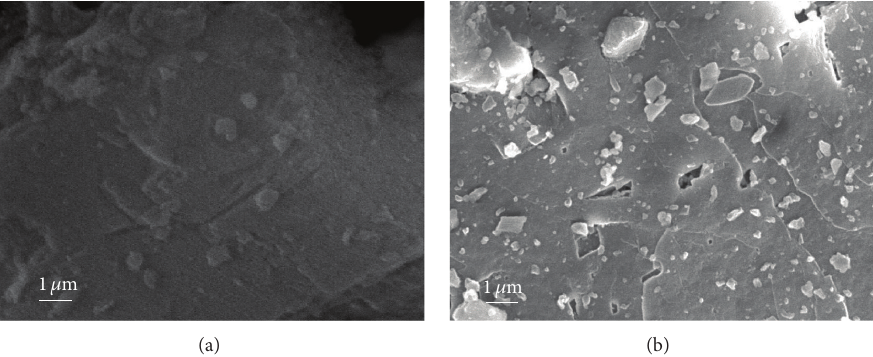
Figure 6: SEM micrographs of dolomite pyrolysis products ((a): Ar and (b): vacuum).